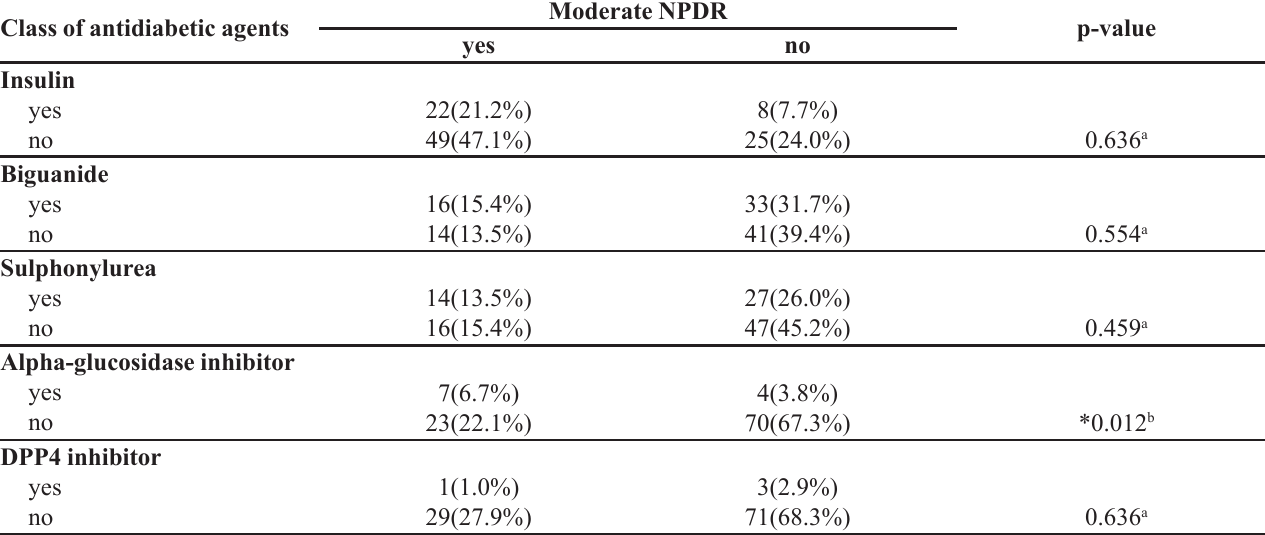
TABLE VI - Association of stages of diabetic retinopathy (DR) with class of antidiabetic agents Class of antidiabetic